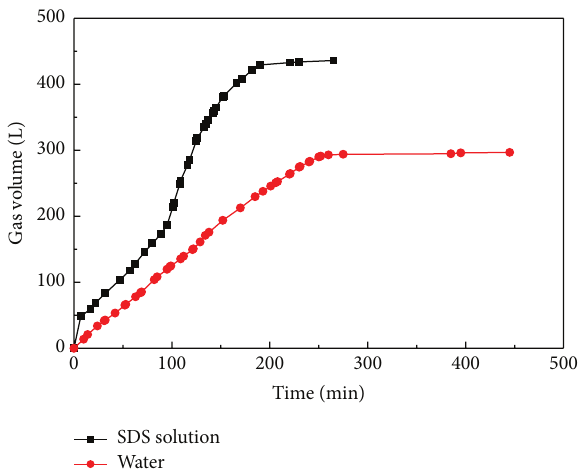
Figure 3: Gas consumption volume versus time for hydrate forma- tion.